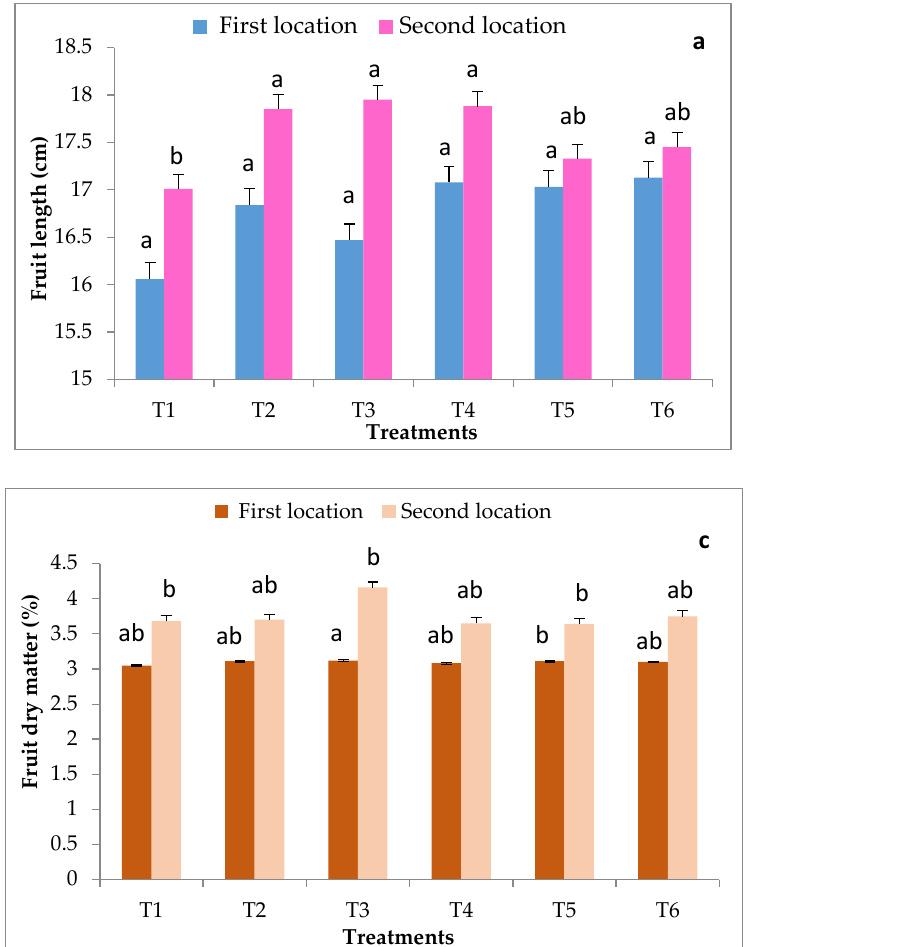
Figure 4. Effects of grafting onto different rootstocks on some fruit quality of cucumber fruits after 70 DAT under heat stress conditions during in both experimental locations including fruit length ( a ), fruit diameter ( b ), fruit dry weight ( c ), ascorbic acid ( d ). Abbreviations: T1, T2, T3, T4, T5 and T6 represent control, Ferro, VSS- 61 F1, Cobalt, Bottle gourd and Super Shintoza. Values are means ± standard deviation (SD) from three replicates. Columns with the same letter are not significant according to Duncan’s multiple range test at p ≤